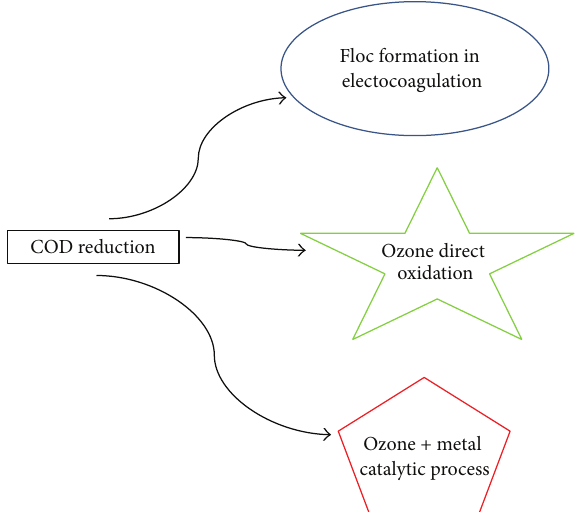
Figure 5: Schematic illustration of all mechanisms that takes place in the coupled EC-ozonation